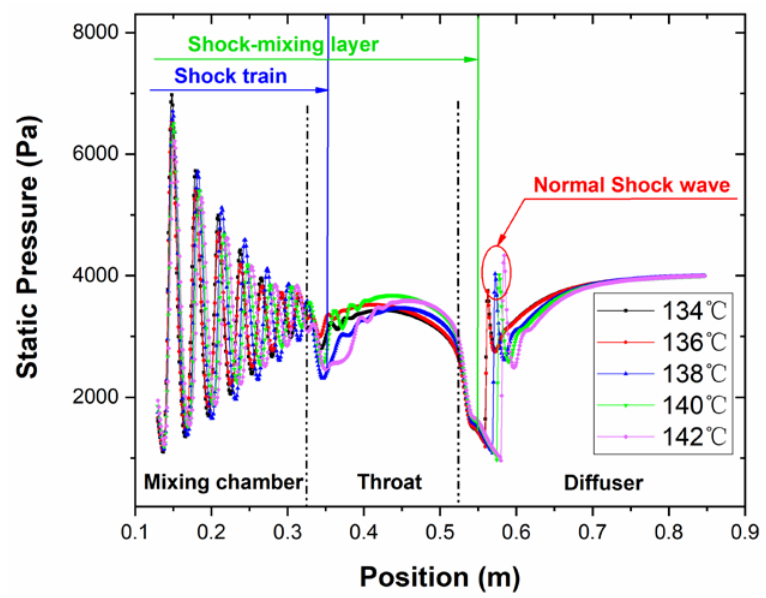
Figure 10. Comparison of static pressure distribution along the axis under di ff erent primary fluid pressure.